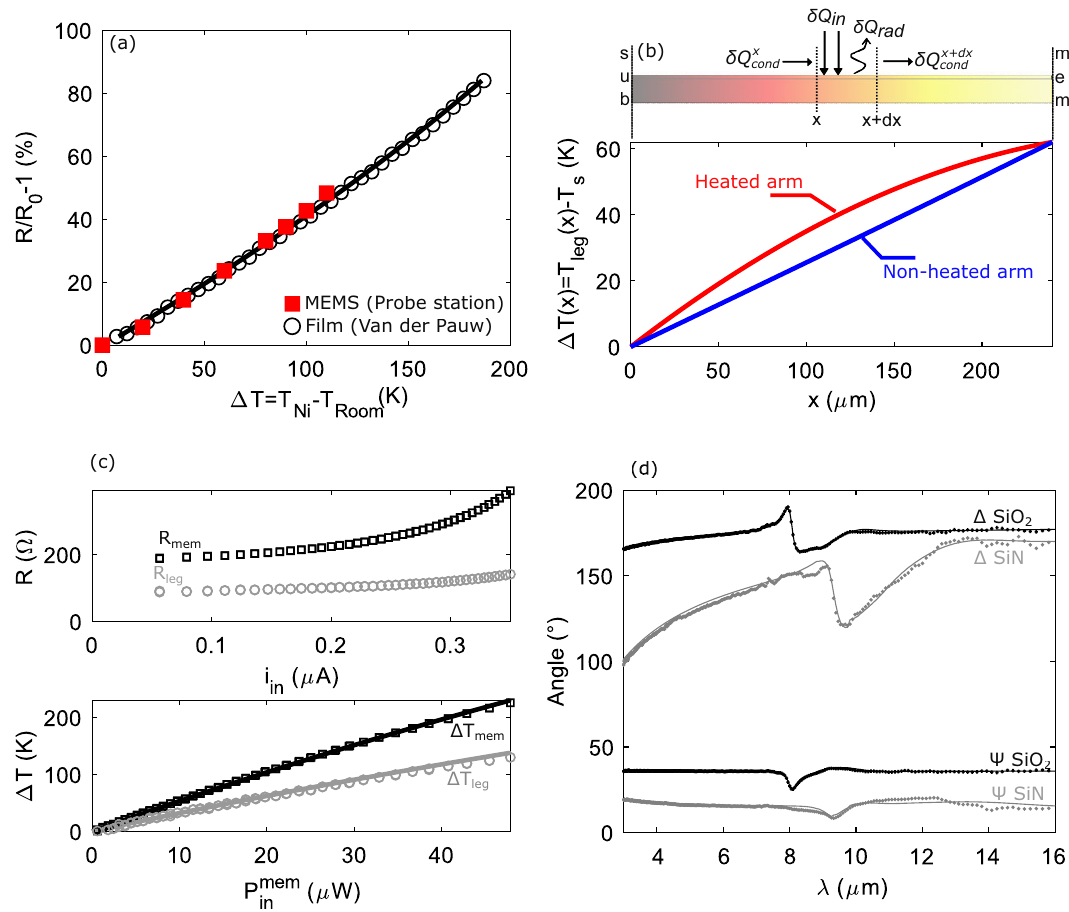
). ( b ) ◦ eq 1 K 1 . ( d ) 5.2 Wm − − leg =